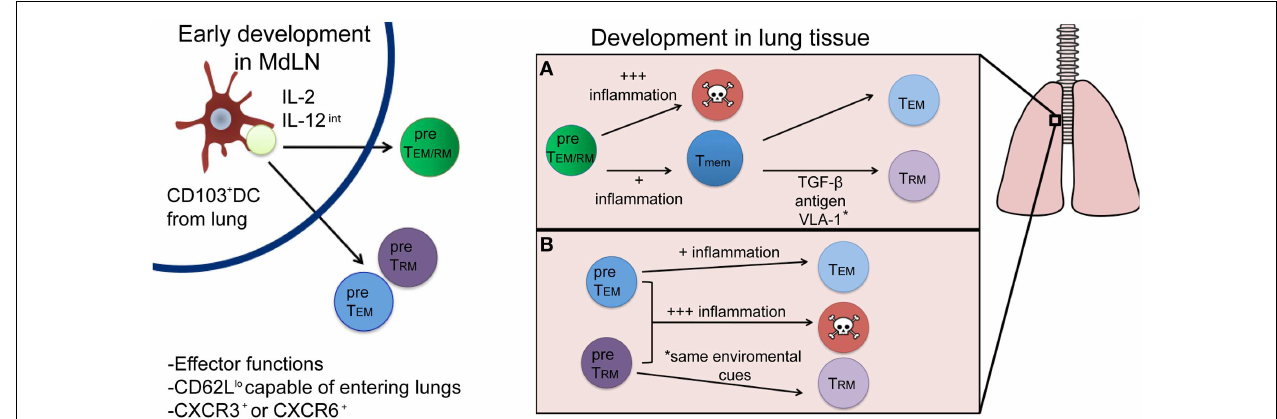
generation of memory cells.While most current evidence supports the differentiation route depicted in (A) , where a common precursor differentiates first into memory, followed by environmentally driven lineage differentiation intoT RM orT EM cells, it is plausible that differentiation into aT RM fate occurs immediately following priming in the lymph node (B) and is distinguished by yet to be discovered phenotypic or genetic